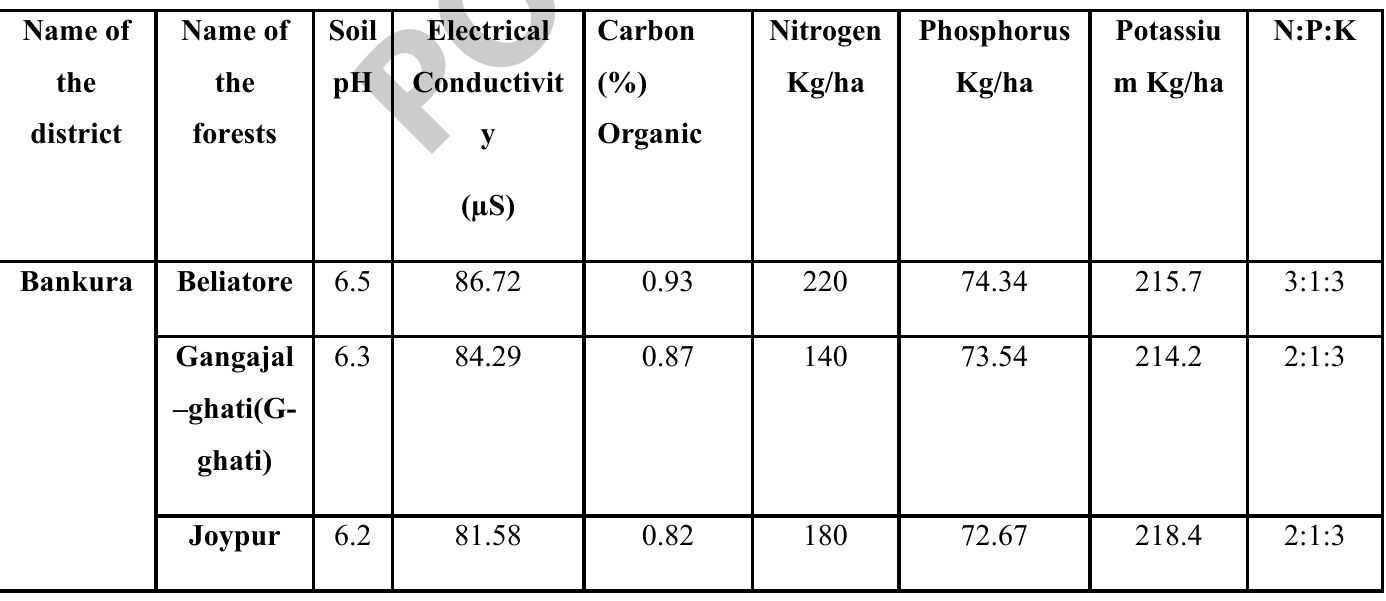
Table 1 Mean values for the soil physico-chemical parameters and the N, P, and K ratios of the soil samples collected at selected quadrants of the Forests in Bankura